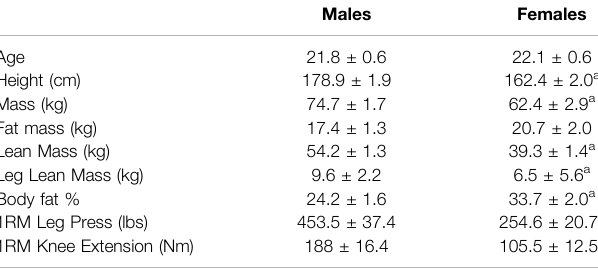
TABLE 1 | Participants ’ baseline